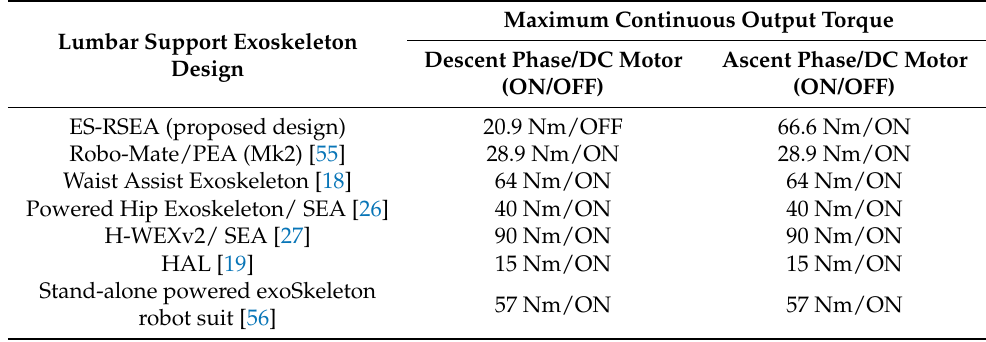
Table 4. Compression of maximum output torque assistance for lumbar support